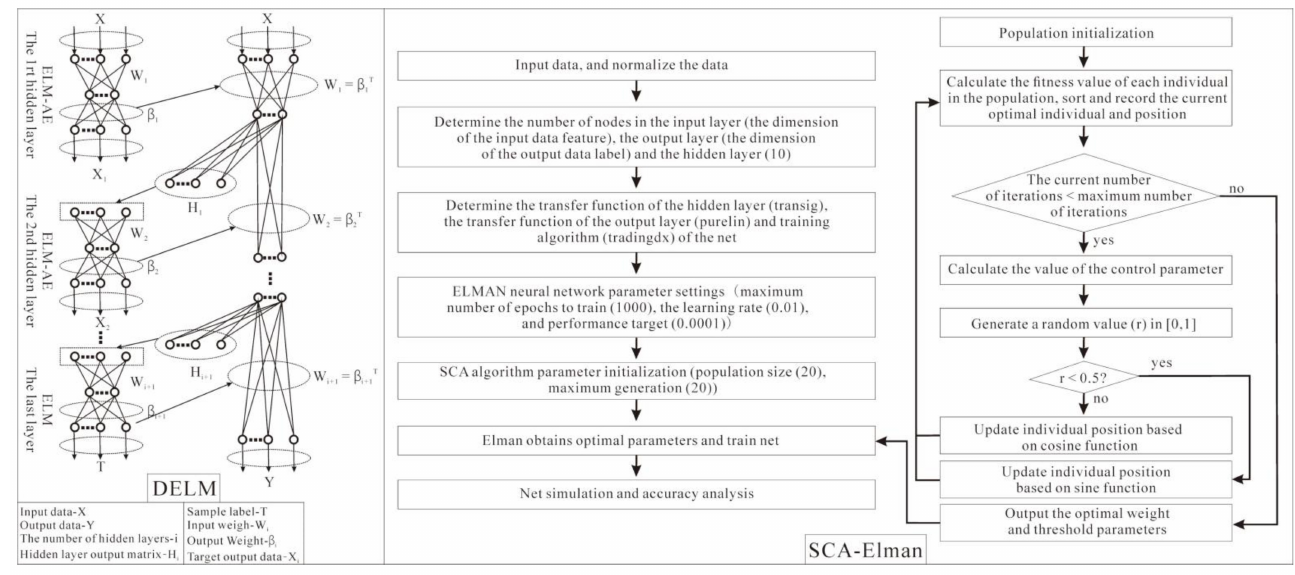
Figure 3. Model structure of DELM and